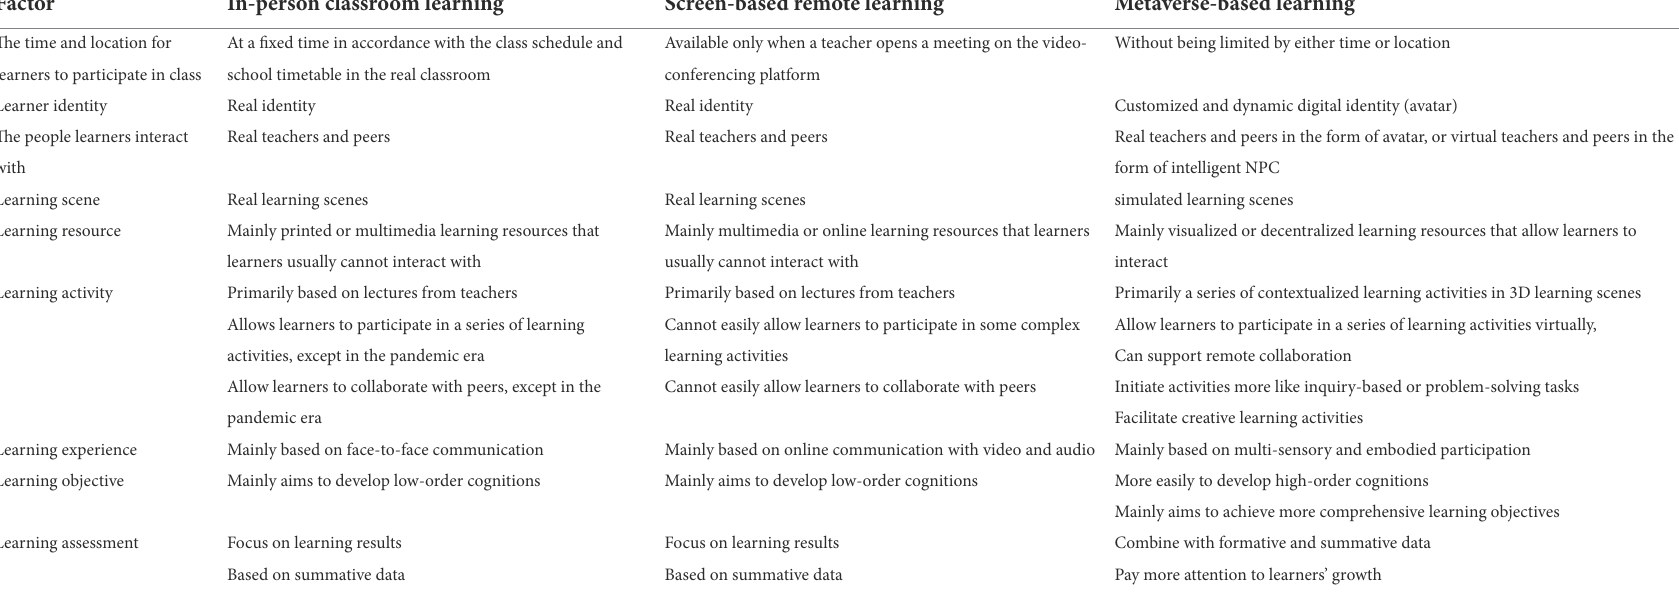
TABLE 1 Comparisons of in-person classroom learning, screen-based remote learning, and metaverse-based learning.